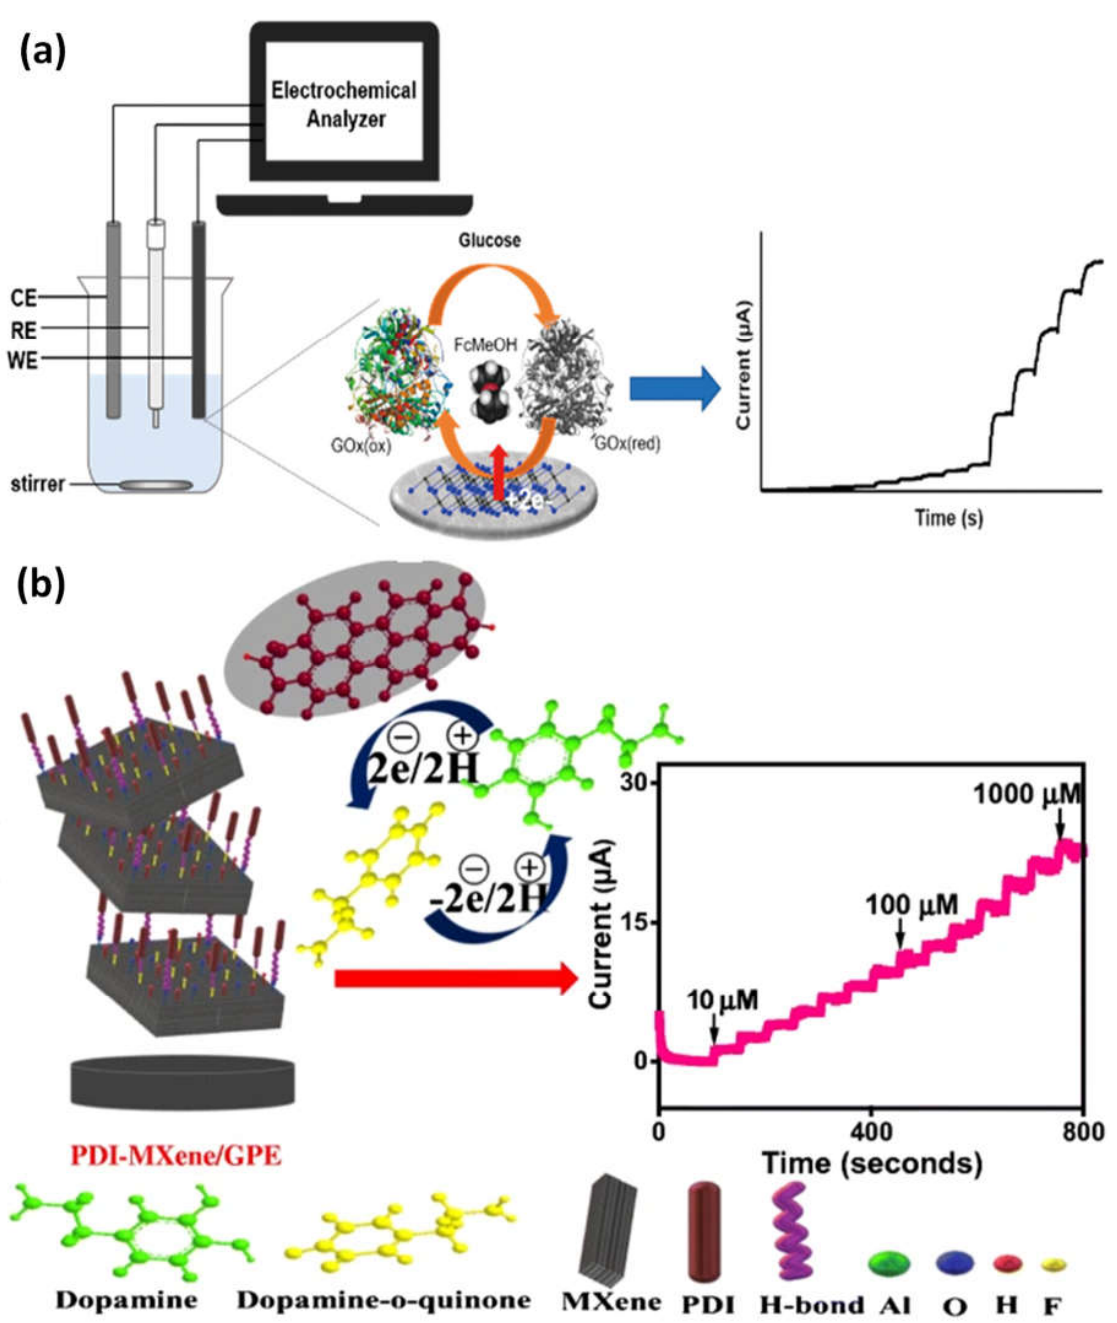
Figure 6. ( a ) An example of a diagram showing how the electrochemical glucose sensor functions; ( b ) a graphitic pencil electrode with perylene diimide-MXene integration for the electrochemical sensing of dopamine and amperometric current-time response curves for the gradual addition of various concentrations of dopamine solution. Reproduced with permission from references [75,76].